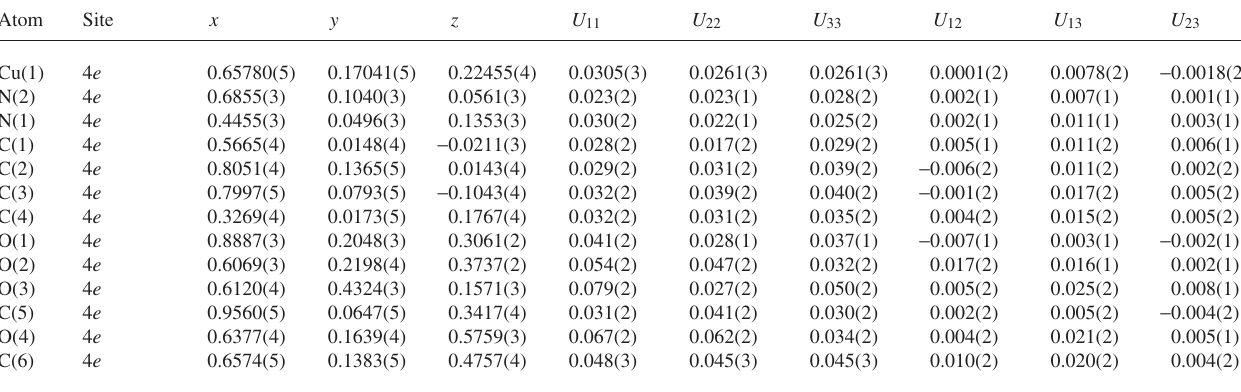
Table 3. Atomic coordinates and displacement parameters (in Å 2 ) .